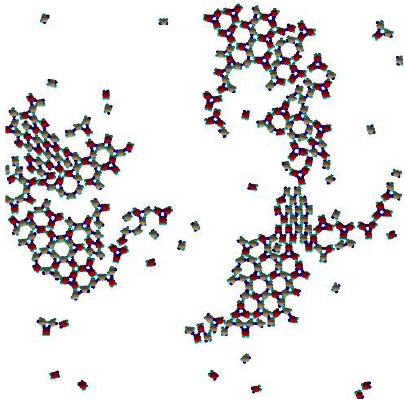
Figure 8. Growth structure from concentration of monomers type I:type II = 1:1, T* = 0.10 after 5.9E7 MC steps – several different domains with rhombohedral and Kagome like placement of the PPs, but without defined periodicity.